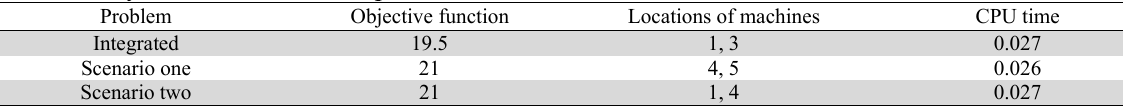
The summary of the results of the optimal